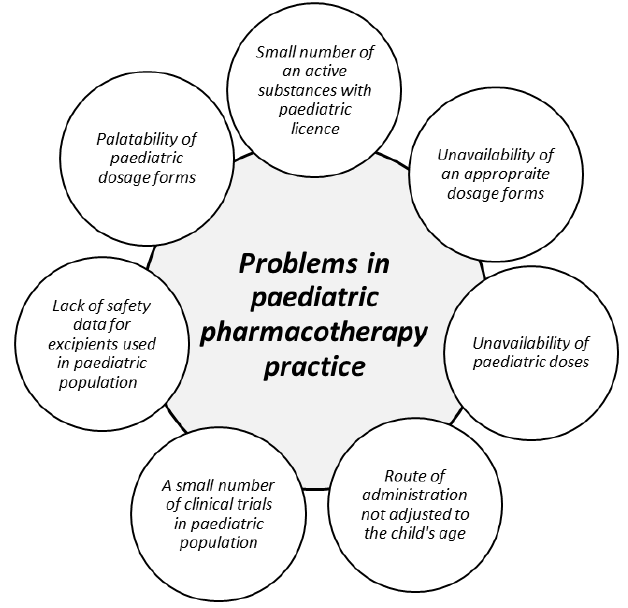
Figure 1. Problems in paediatric pharmacotherapy practice [11,19,20].